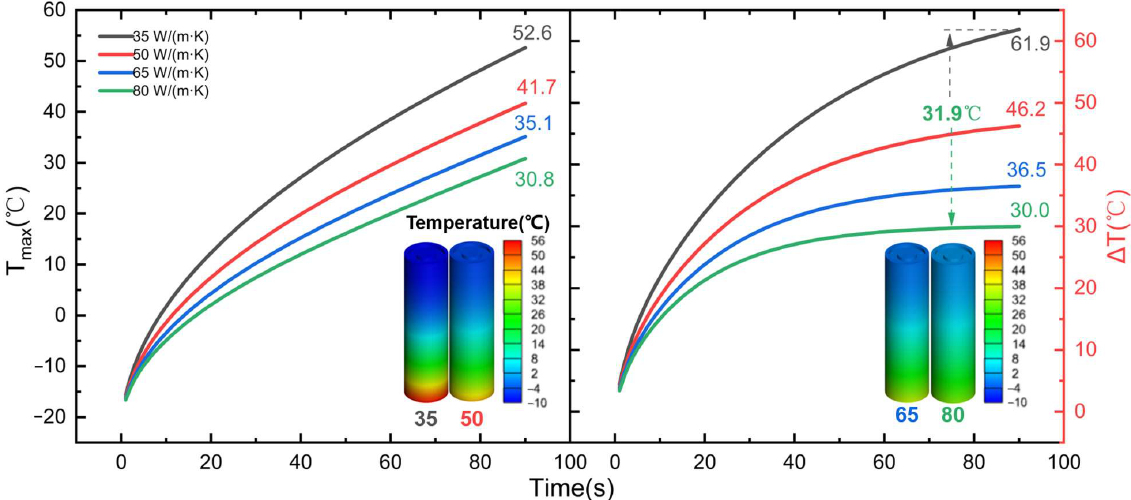
Figure 10. Evolution of the temperature and distribution of the internal temperature of the cell with different thermal conductivity: Maximum temperature ( Left ); Temperature difference ( Right ).